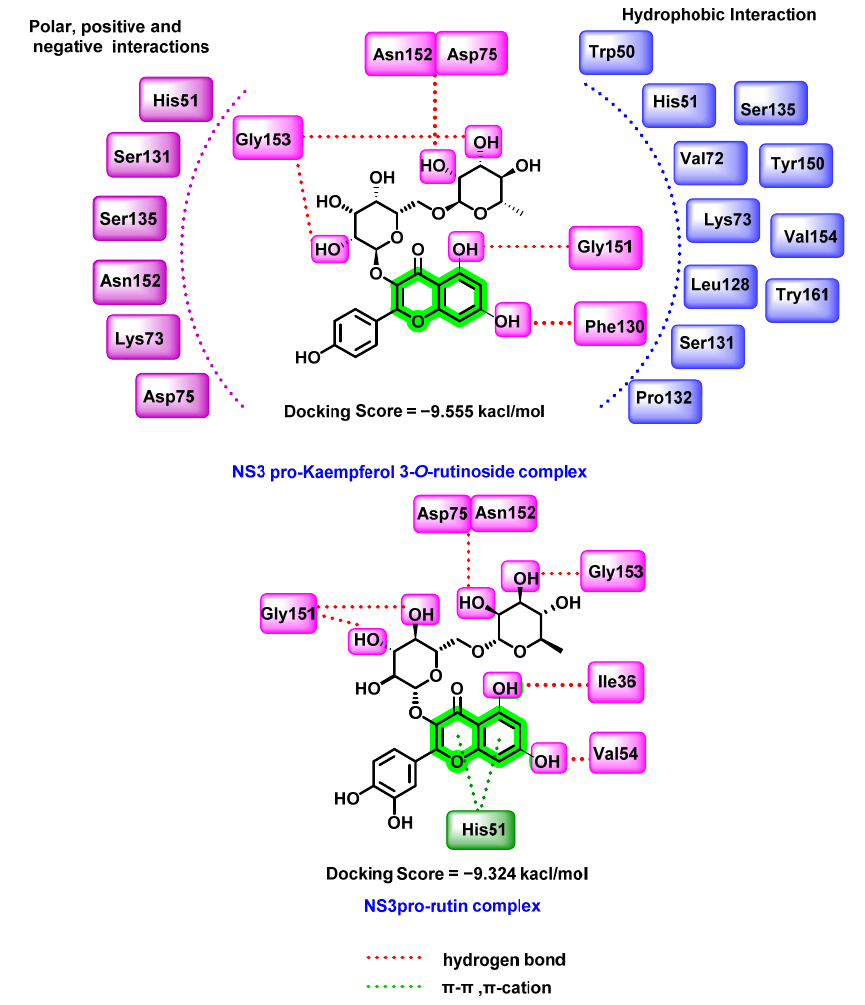
Figure 9. Docking interactions of kaempferol-3- O -rutinoside, rutin with the DENV NS3 protein.